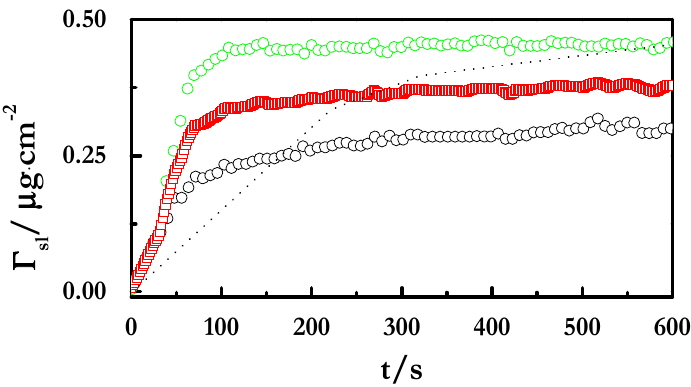
Figure A2. Time dependence of the surface excess at the solid/liquid interface, as was obtained using a quartz crystal microbalance for the adsorption of PDADMAC–SLES mixtures with three different concentrations (o (SLES) = 2.62 µ M, o (SLES) = 15 µ M and o (SLES) = 2.62 mM) on a silicon wafer and PDADMAC concentration of 5 g/L. The dotted black line corresponds to the hypothetical surface excess corresponding to the adsorption of an evaporating droplet with an initial [SLES] = 2.62 µM.